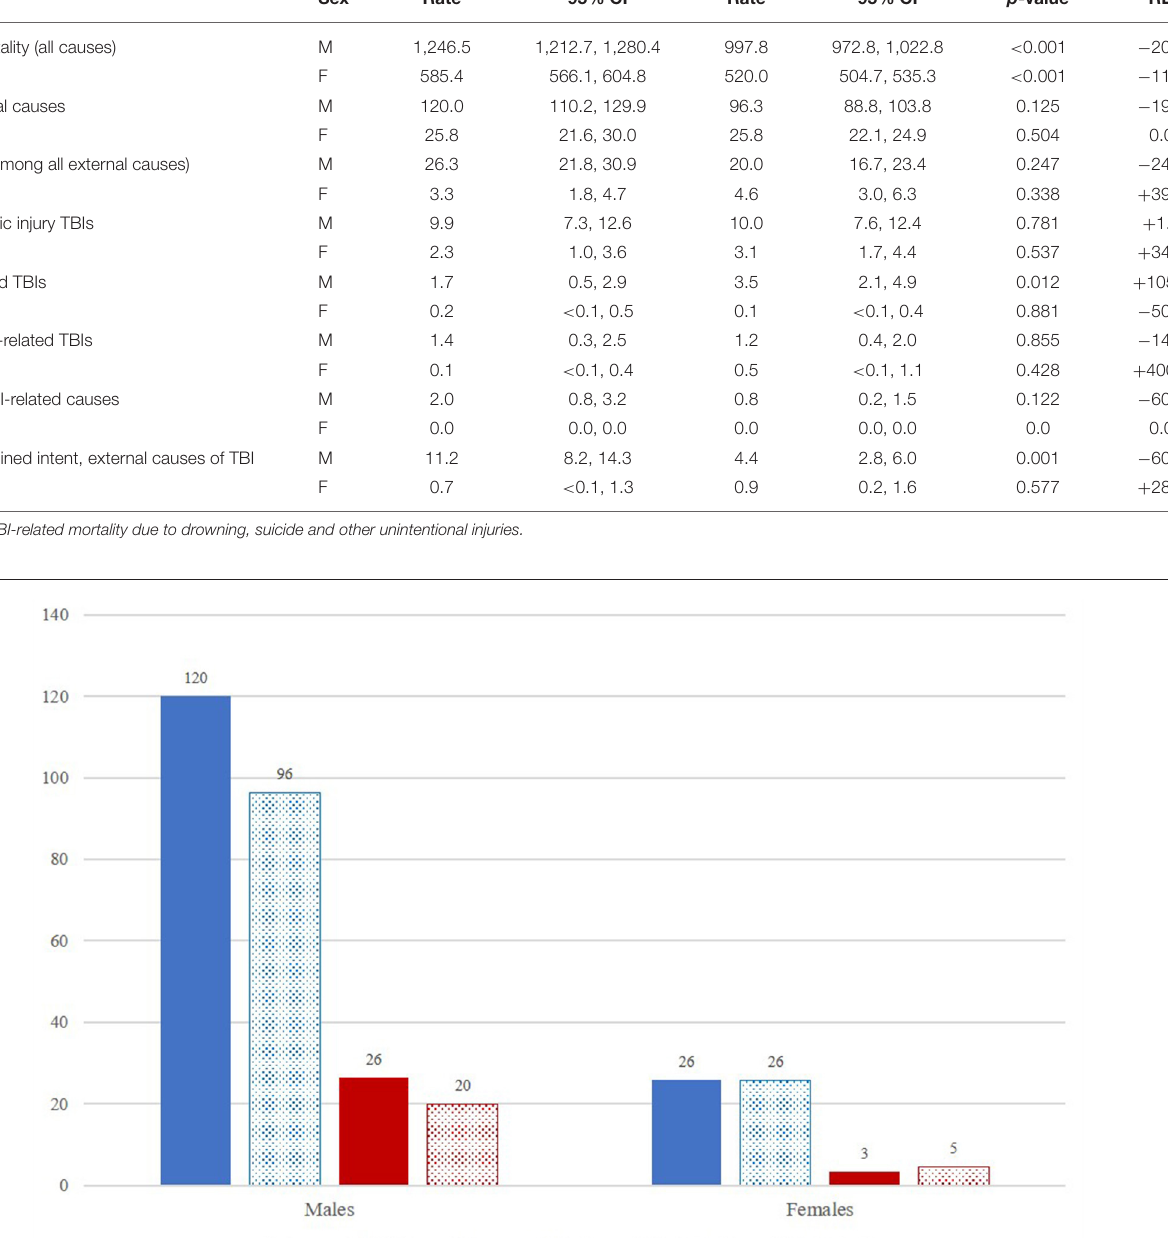
injuries was 10.0 (95% CI 8.2, 11.8) in males and 2.7 (95% CI 1.8, 3.6) in females. These findings emphasise that road traffic injuries are the leading contributor to TBI-related mortality in both males and